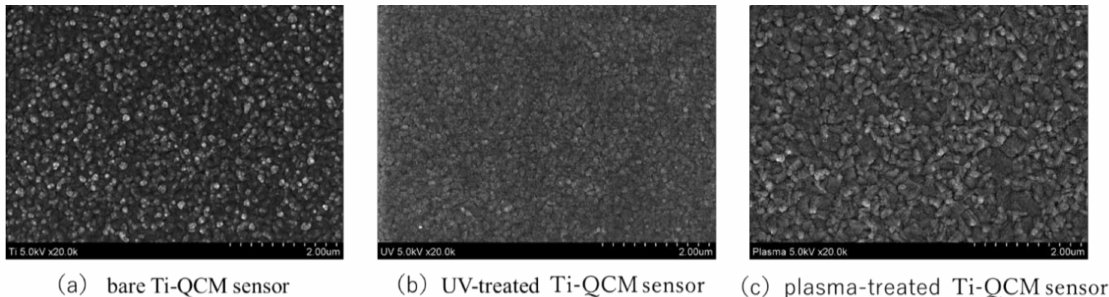
Figure 1. SEM images of ( a ) bare, ( b ) UV-treated, and ( c ) plasma-treated Ti quartz crystal microbalance (QCM)